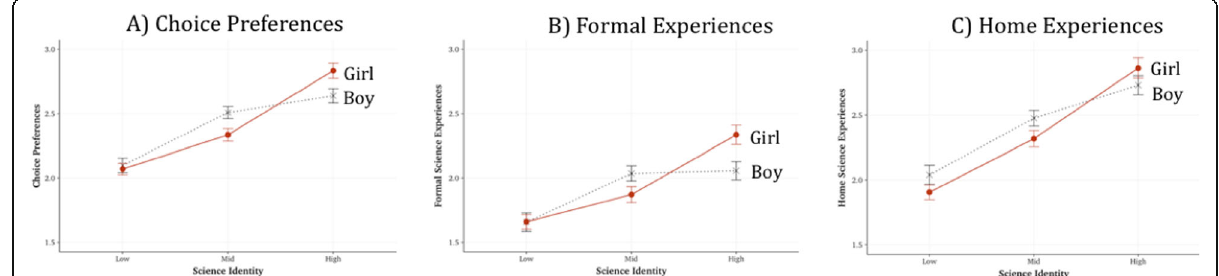
Fig. 1 Estimated marginal means (with SE bars) of a choice preferences, b formal science experiences, and c home science experiences, predicted by science identity (low, moderate, and high levels) and